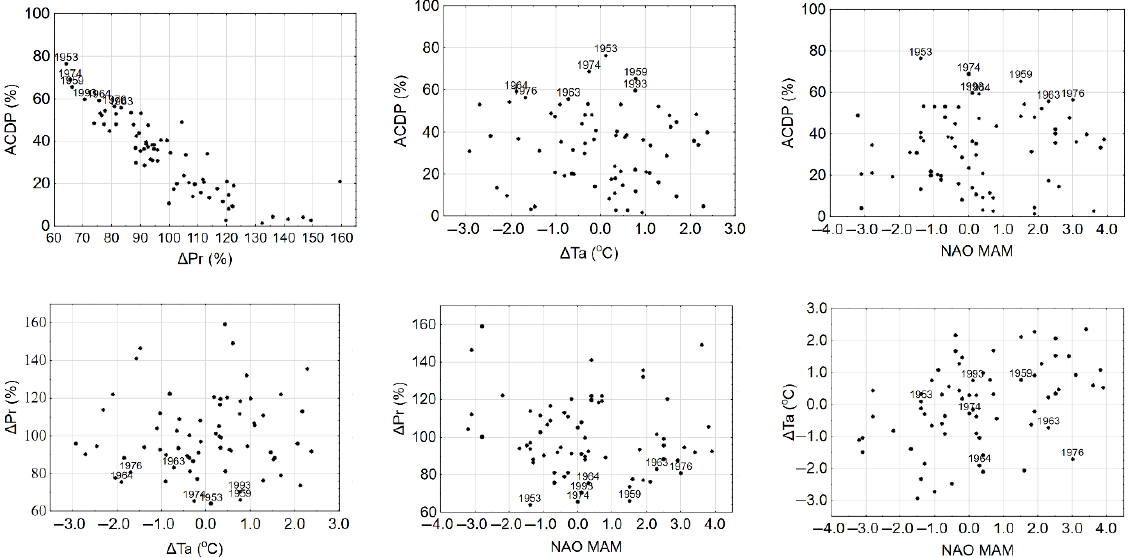
Figure 10. Spring value of ACDP in Poland against precipitation variability ( ∆ Pr), thermal conditions of air ( ∆ Ta) and air pressure conditions (NAO MAM) in 1951–2018 and the dependence of ∆ Pr on ∆ Ta and NAO MAM, and the dependence of ∆ Ta on NAO MAM (the charts only indicate the 9 years with the highest value of ACDP). Notes: ACDP—area of the country covered by deficient precipitation (%), NAO MAM—the North Atlantic Oscillation index in spring, ∆ Ta—deviation of mean area air temperature from the multi-year mean in spring ( ◦ C), ∆ Pr—area spring precipitation expressed as a percentage of the mean multi-year precipitation (%).